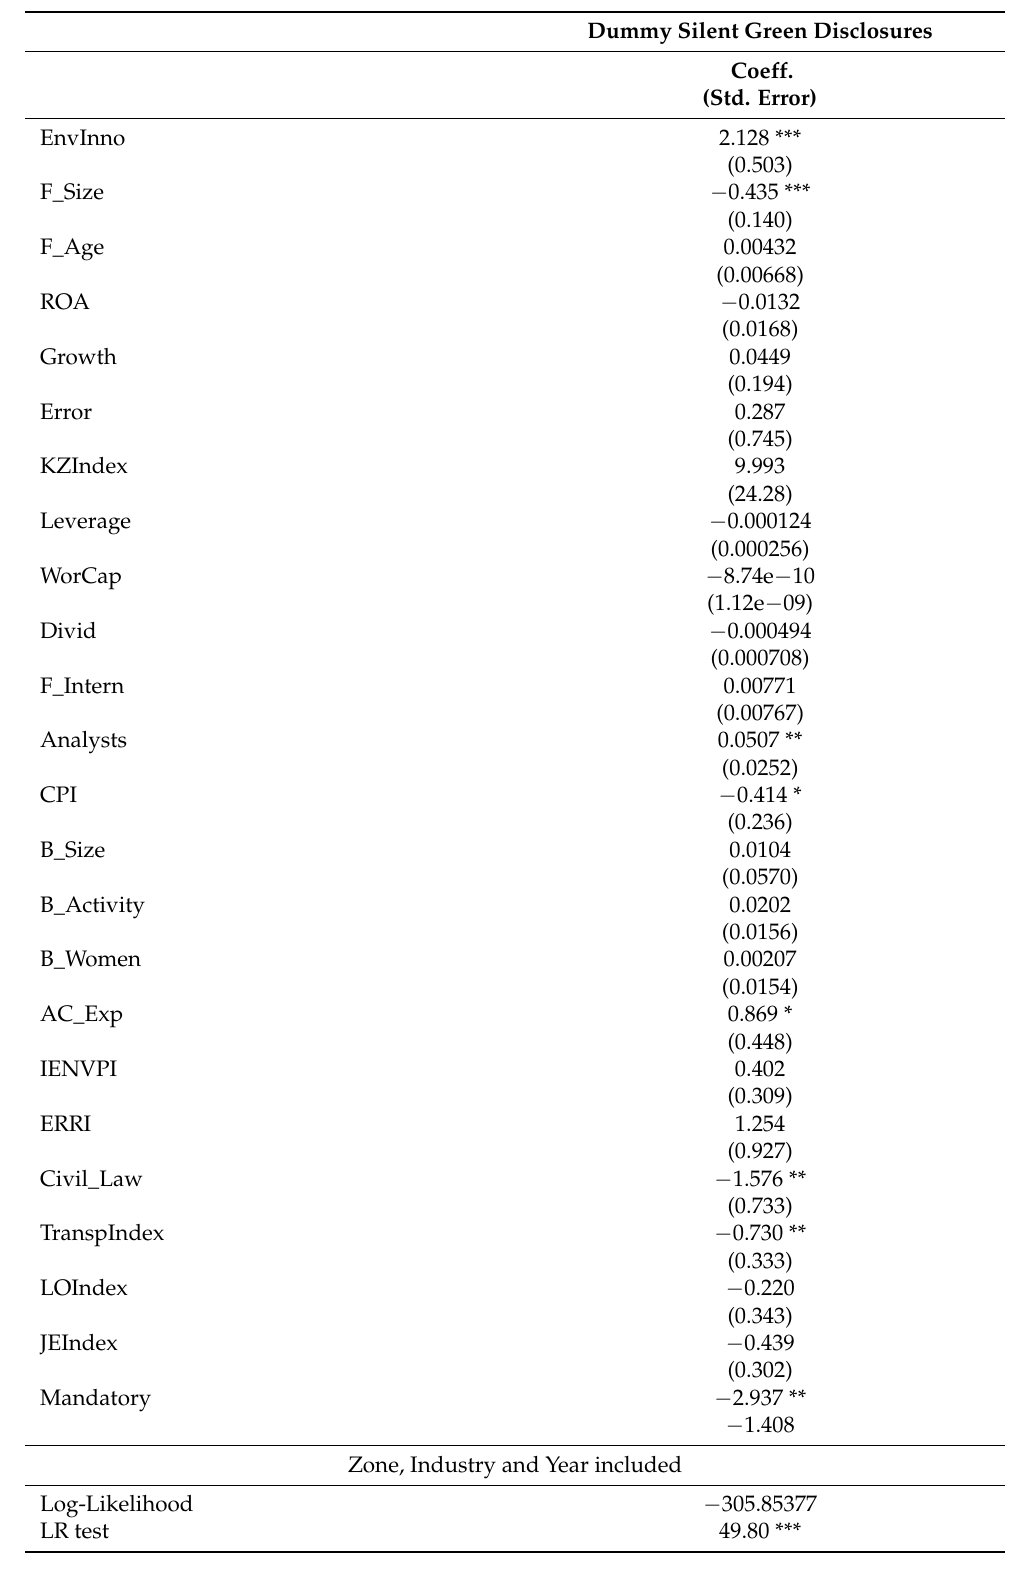
Table 5. Complementary